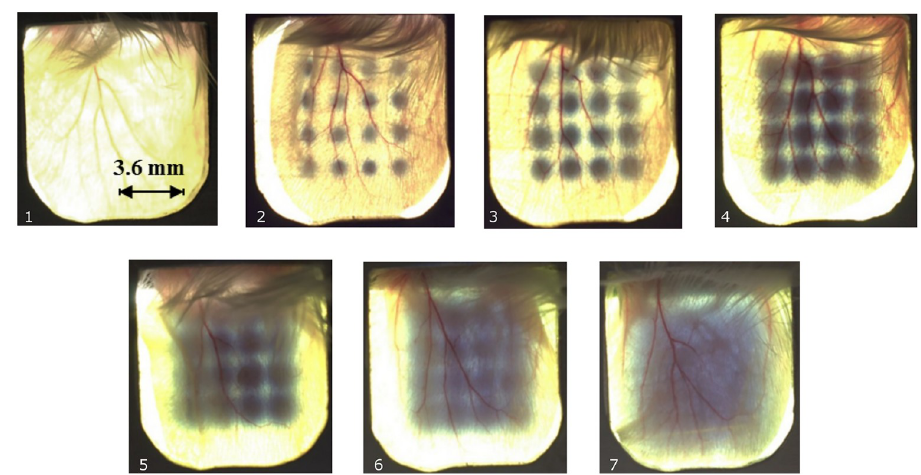
Fig 2. Gafchromic films mounted behind mouse ears show the irradiation pattern for non-irradiated ears (1) and irradiations with σ /ctc-ratios of 0.053 (2), 0.11 (3), 0.17 (4), 0.23 (5), 0.31 (6) and 0.49 (7) at ctc = 1.8 mm each. (7) corresponds to a homogeneous dose distribution. Owing to the limited sensitivity range of the films, no absolute dose values or minibeam sizes can be extracted from these images.